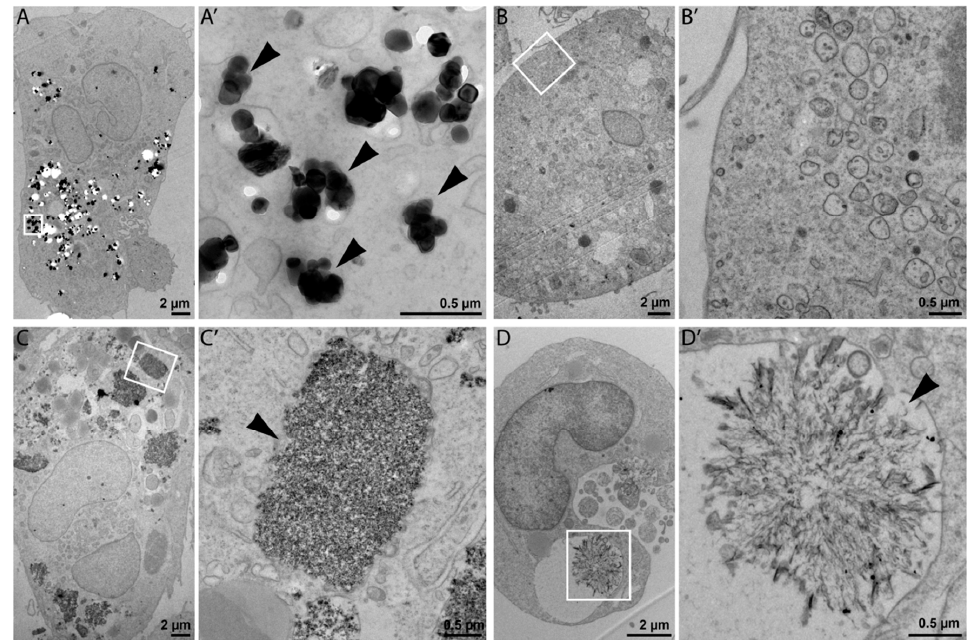
Figure 2. Representative TEM images of THP-1 cells incubated with 25 µg of NPs for 24 h: NM-100 ( A , A’ ); NM-110 ( B , B’ ); NM-200 ( C , C’ ), and NM-300 K ( D , D’ ). For each type of NP in the pair of images, the left image represents the view of a whole cell ( A – D ), and the image to the right represents high magnification detail ( A’ – D’ ) delineated by a white rectangle in the respective low magnification image. Bars, 2 µm ( A – D ); 0.5 µm ( A’ – D’ ).